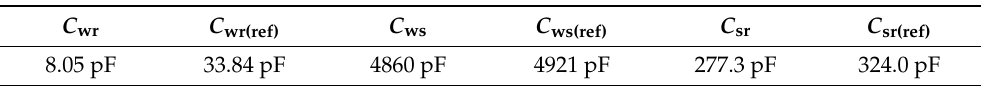
Table 3. Parasitic capacitances of the model with two shielding windings compared to the capacitance values of the reference